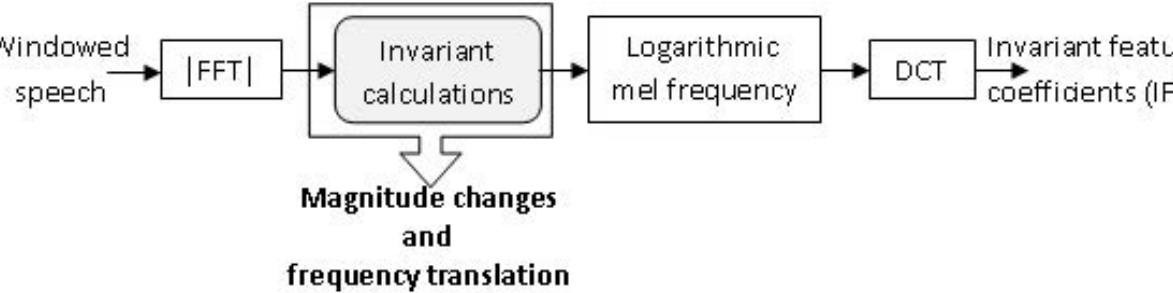
Figure 4. Steps for computing invariant feature